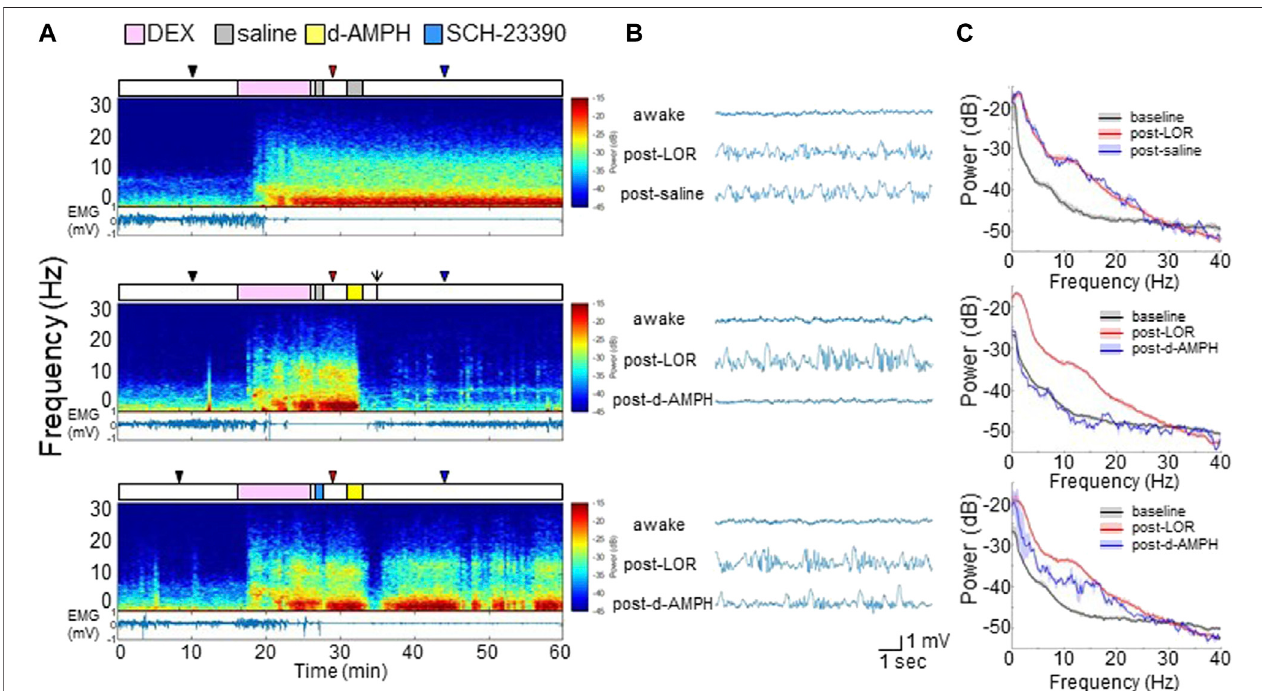
FIGURE 3 | D-amphetamine restores awake-like neurophysiology in the PFC after dexmedetomidine. (A) Experimental time courses, spectrograms, and EMG recordings from a representative rat. The arrow indicates ROR. (B) Raw LFP waveforms from each time period. (C) The median and 95% CI of power spectral density during awake (black), post-LOC (red), and 10 min after saline or d-amphetamine